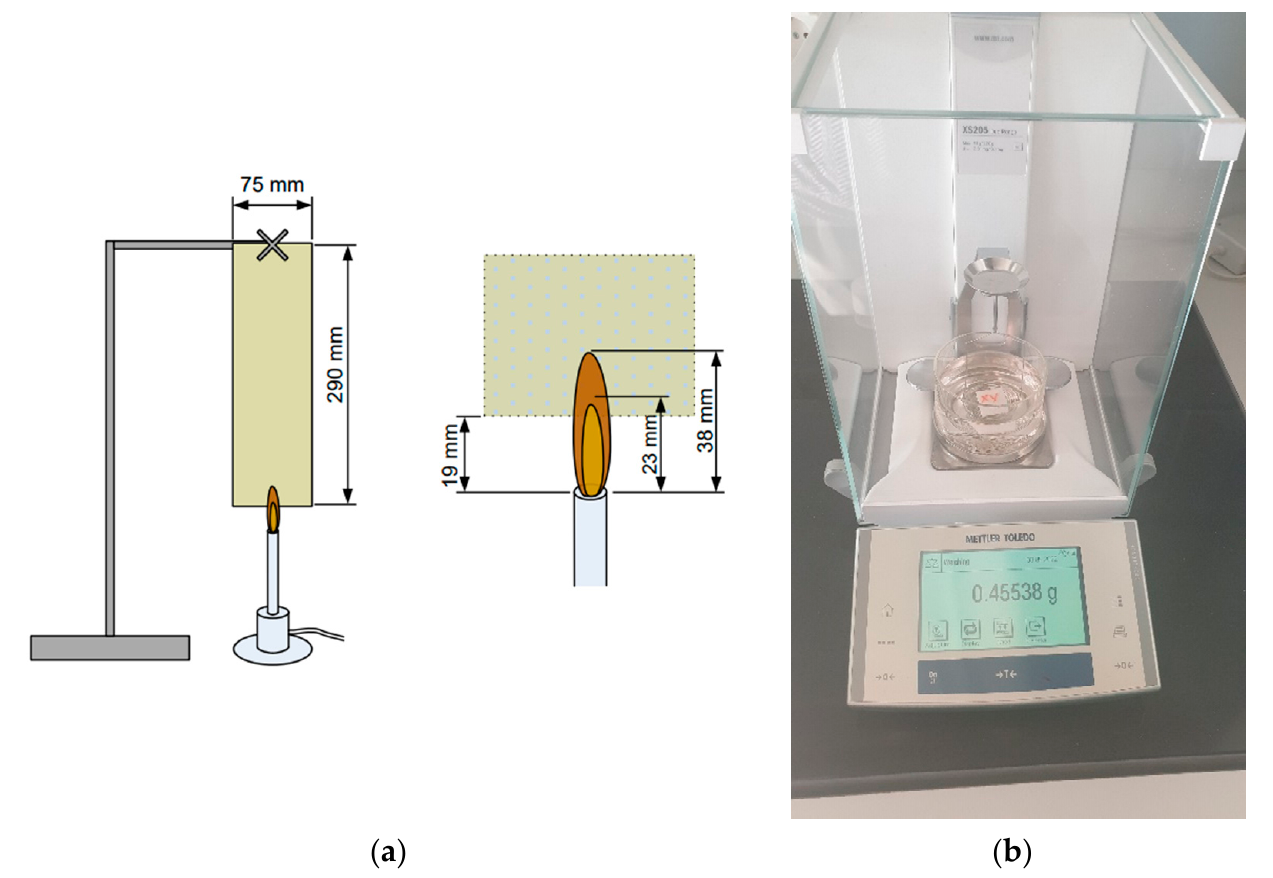
Figure 2. Schematic presentation of a vertical burn test [8] ( a ) and hydrostatic weighting of the test sample printed in XY direction ( b ). Reprinted with permission from [8], CC BY-NC-SA 3.0 NZ, 2014,